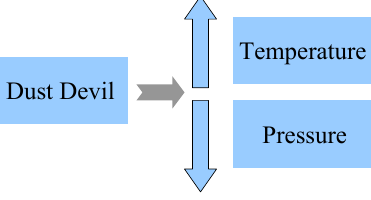
Fig. 2. A dust devil implies a temperature rise and a pressure drop.